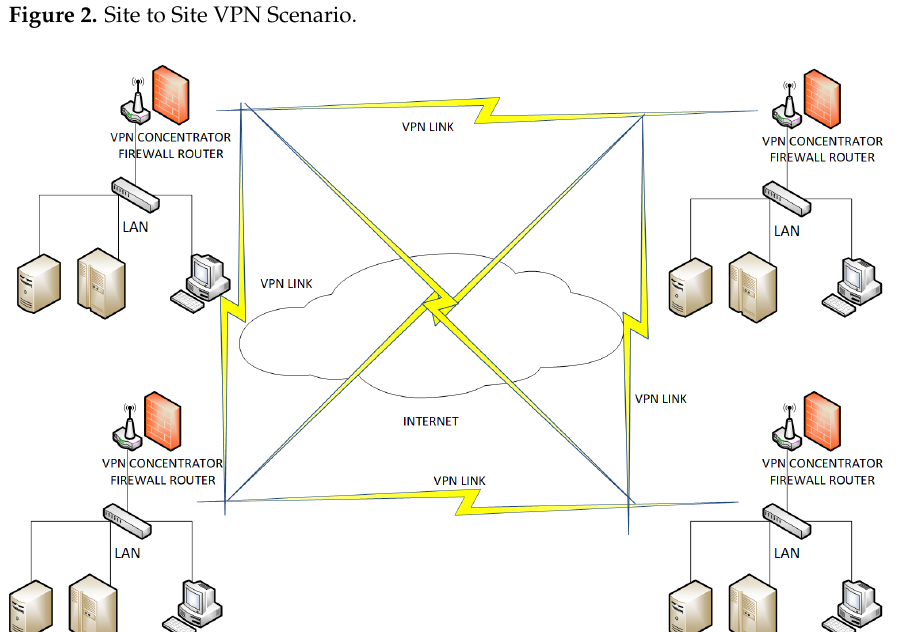
Figure 3. Site to Multi Site VPN